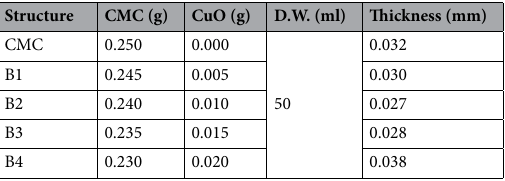
Table 1. Sample coding according to CuO-NPs concentration and the thickness of CMC and CMC/CuO nanocomposite films.